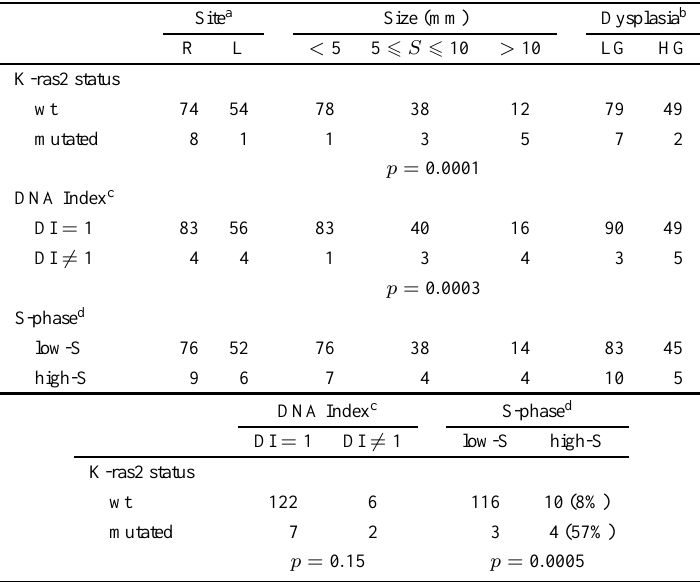
a Site was right (R) or left (L) colon: R includes caecum, ascending colon, hepatic flexure, and transverse colon; L includes splenic flexure, descending colon, sigmoid colon, and rectum.